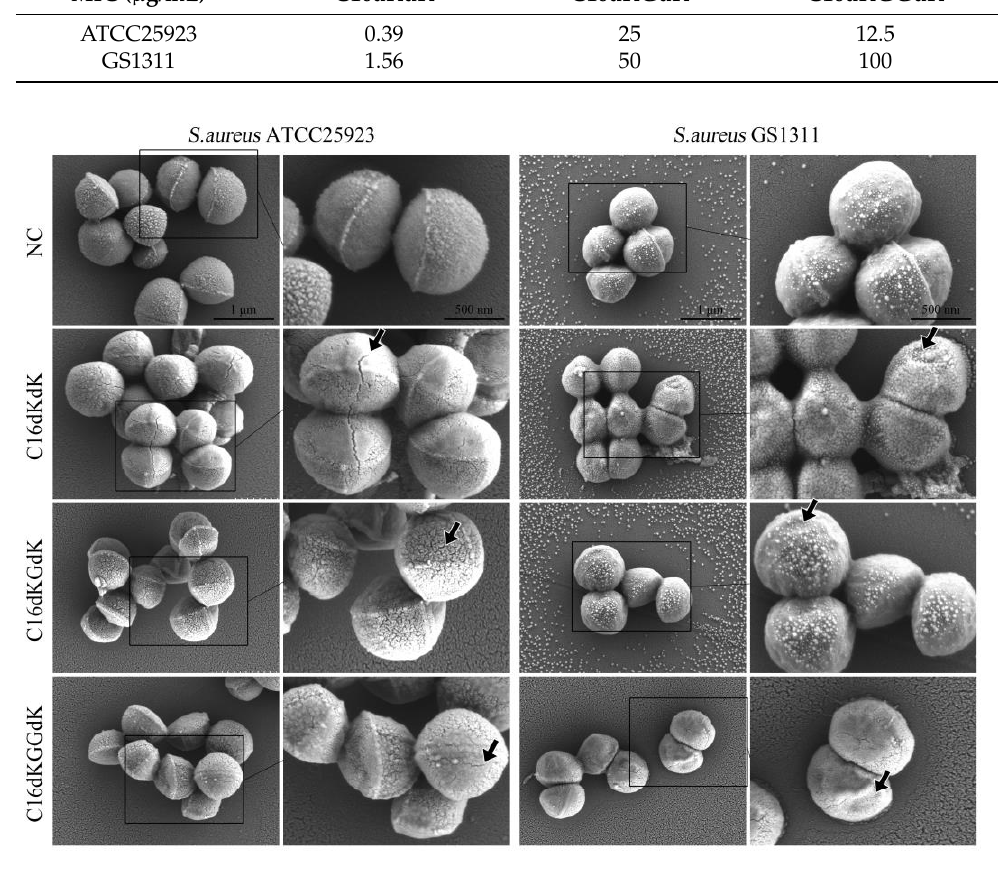
Figure 2. Lipopeptide antimicrobial activity. SEM analysis of morphological alterations in S. aureus cells after treatment with three lipopeptides. The first column has magnifications of 30 kw× in the various treatment groups, while the second has magnifications of 60 kw×. (The arrows indicate the morphological changes developed on the bacterial surface after treatment with different lipopeptides of S. aureus ).